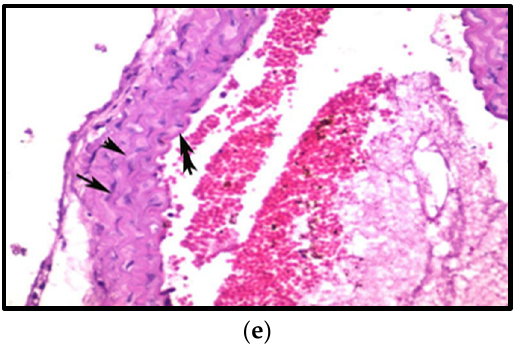
Figure 8. Histology of aortic section stained with hematoxylin and eosin (original magnification ×200) from each group: G5: high-cholesterol diet (Ch); G6: Ch + Lp + Lc; G7: Ch + Sp; G8: Ch + Lp + Sp; G9: Ch + rosuvastatin. ( a ) G5: Section in aorta showing fibrin deposits on surface of endothelium layer of tunica intima and marked reduction in thickness of tunica media (H&E. 400×). ( b ) G6: Section in aorta showing irregular endothelium layer, and vacuolation of tunica intima together with pyknotic nuclei of smooth muscle, as well as little reduction in thickness of tunica media (H&E. 400×). ( c ) G7: Section in aorta showing multiply irregular endothelial layers in tunica intima, pyknotic nuclei of smooth muscle and normal thickness of tunica media (H&E. 400×). ( d ) G8: Section in aorta showing normal appearance of tunica intima (arrow), smooth muscle (arrow) and elastic lamellae (two head arrow) in tunica media) (H&E. 400×). ( e ) G9: Section in aorta showing intact endothelium layer (two head arrow), smooth muscle (arrow) and elastic lamellae (arrowhead) in tunica media (M). (H&E. 400×).